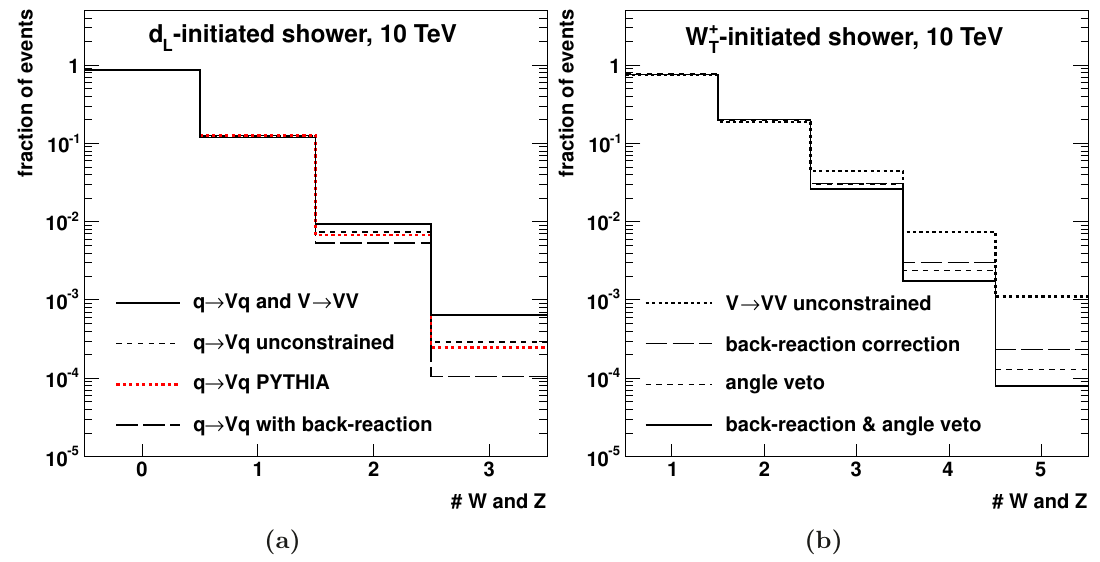
Figure 5. Normalized rates versus the number of multiple final-state W/Z emissions with a 10 TeV initial state particle, (a) d L -initiated showers for q V q and V V V splittings with full EW → → FSR (solid histogram), q V q splitting only (long-dashed), and q V q without back-reaction → → correction (short-dashed). Output from PYTHIA q V q weak shower is also included for comparison → (dotted histogram). (b) W T -initiated showers for fully constrained FSR (solid histogram), compared with various stages of approximations as